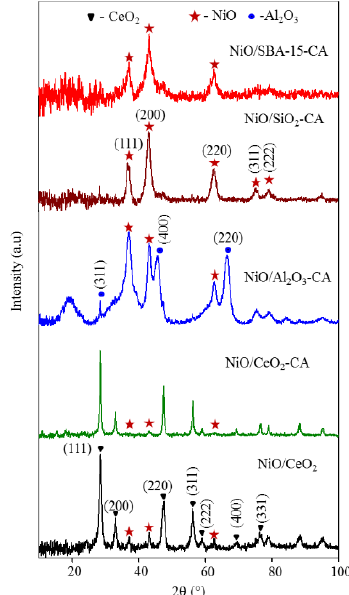
Figure 1. X-ray di ff raction (XRD) patterns of di ff erent catalysts. Figure 1. X-ray diffraction (XRD) patterns of different catalysts. Figure 1. X-ray diffraction (XRD) patterns of different catalysts.